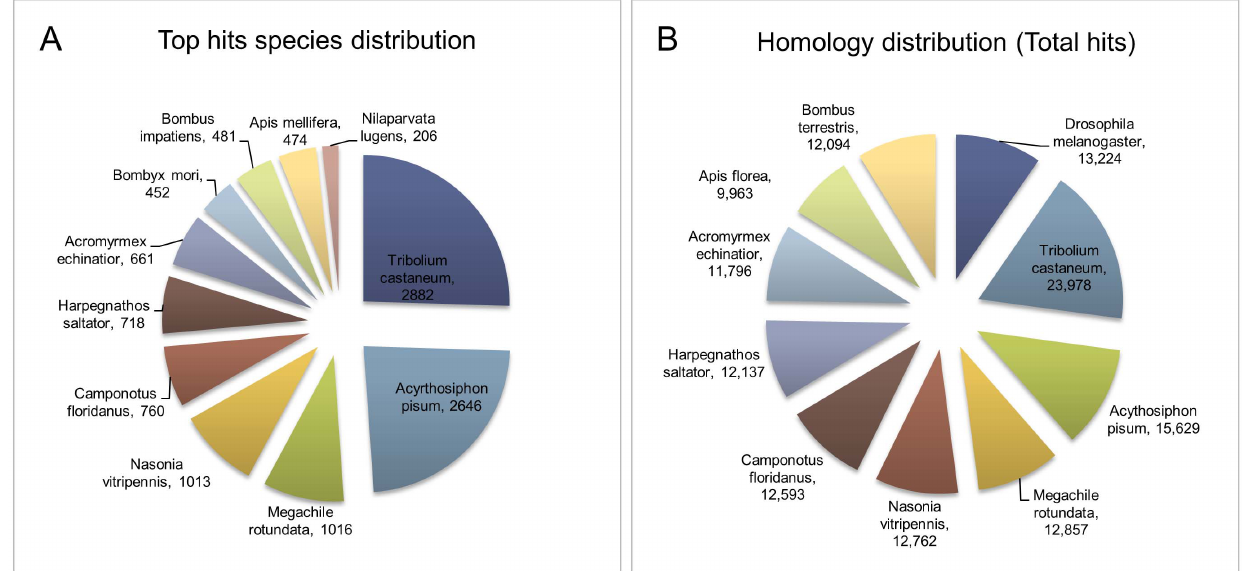
Figure 2. BLAST distribution and homology of the H.vitripennis contigs. Pie diagrams showing the homology distribution A ) Top hit species distribution of H. vitripennis contigs against those of other insect species and B ) Total species homology distribution of H. vitripennis contigs against other insects.